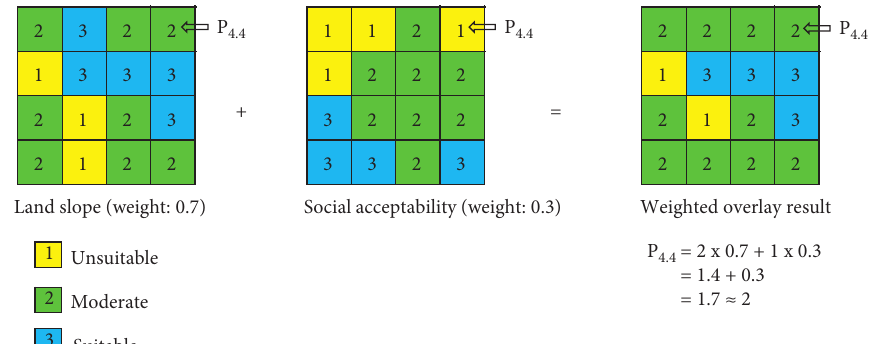
Figure 9: The weighted overlay analysis between two subfactors. Each coordinate in the pixel reflects the location. Parameters 1 (yellow), 2 (green), and 3 (blue) indicate the unsuitable, moderate, and suitable location classes for landfill site selection, respectively. The calculation step of the weighted overlay at each location is represented by pixel coordinate P 4,4 (modified from Wijayanto et al.